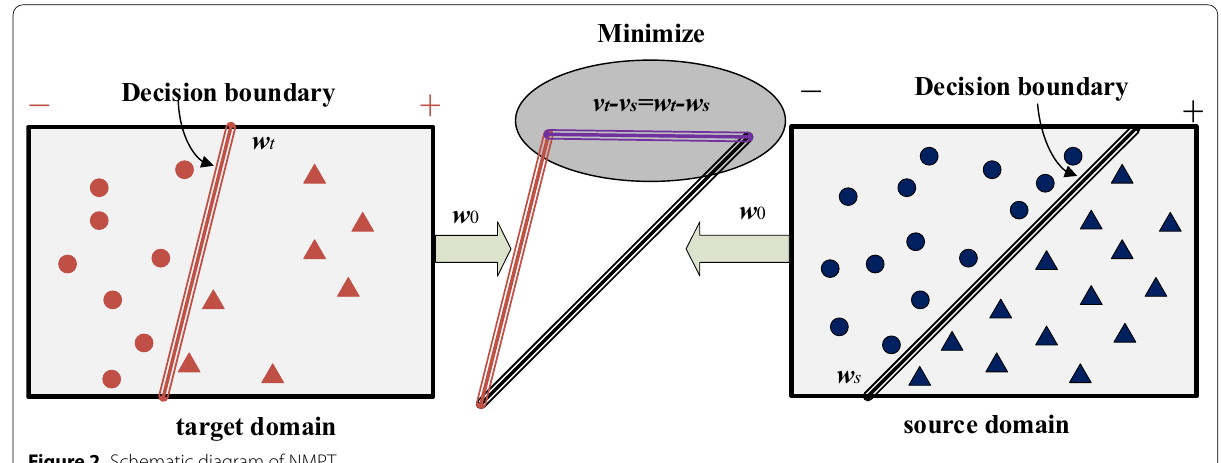
Figure 2 Schematic diagram of